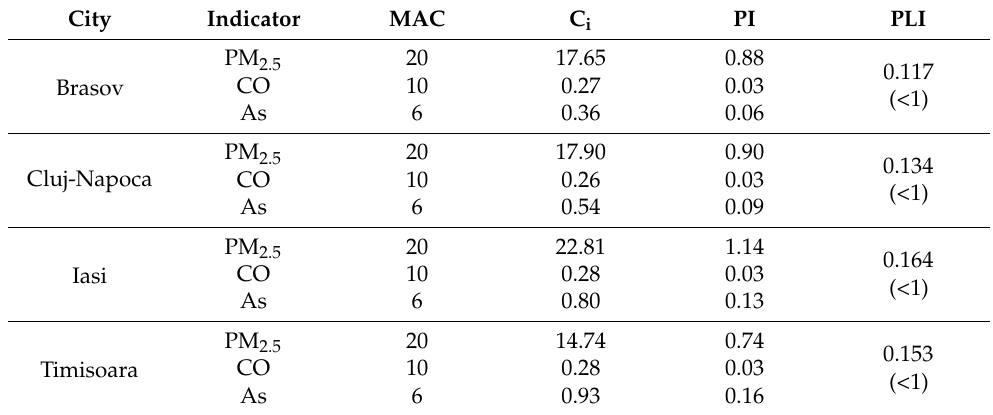
Table 4. Calculation of the air pollution load index in Brasov, Cluj-Napoca, Iasi, and Timisoara.